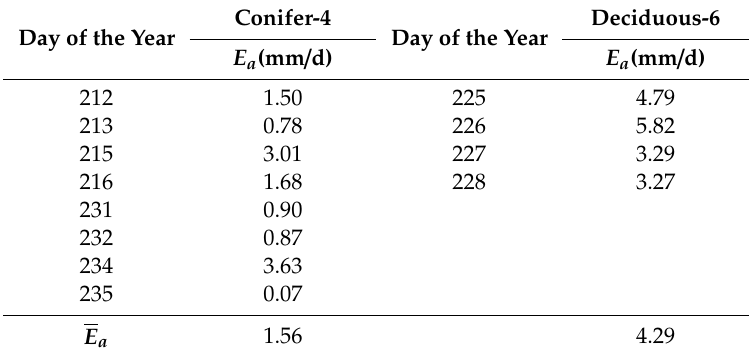
Table 2. Penman–Monteith E a and E a estimates during the same days that sap flow was measured at each site (in 2004). E a is the daily E a